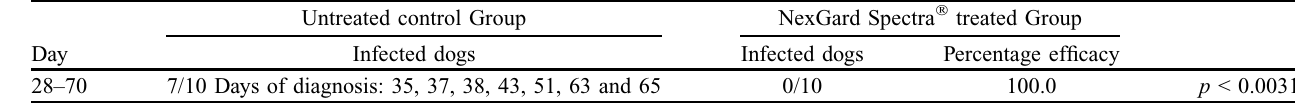
Table 4. Number of dogs infected by Dipylidium caninum